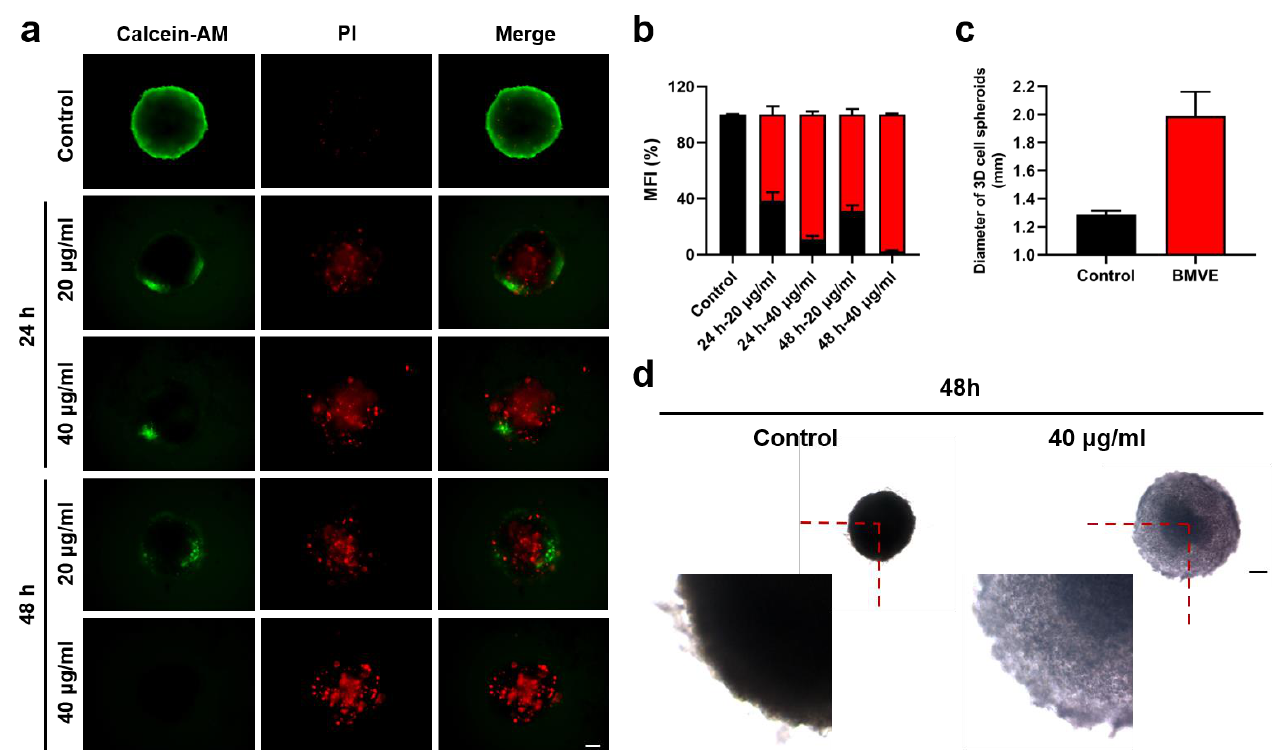
Figure 4. Effect of BMVE on 3D-cultured 4T1 cells. ( a ) After treating 3D-cultured 4T1 cells with 20 and 40 µ g/mL BMVE for 24 and 48 h, respectively, the 3D cell spheroids were double stained with calcein-AM/PI. Cell survival (green fluorescence) and cell death (red fluorescence) were observed using a fluorescence microscope (scale bar = 50 µ m). ( b ) Quantitative statistics of the fluorescence ratio of green and red in 3D cell spheroids (black represents green fluorescence ratio; red represents red fluorescence ratio). ( c ) Quantitative statistics of 3D cell spheroids’ diameter in the control group and the BMVE-treated group at 48 h. ( d ) After treating 3D-cultured 4T1 cells with 40 µ g/mL BMVE for 48 h , the 3D cell spheroids were observed using a microscope (scale bar = 300 μm).